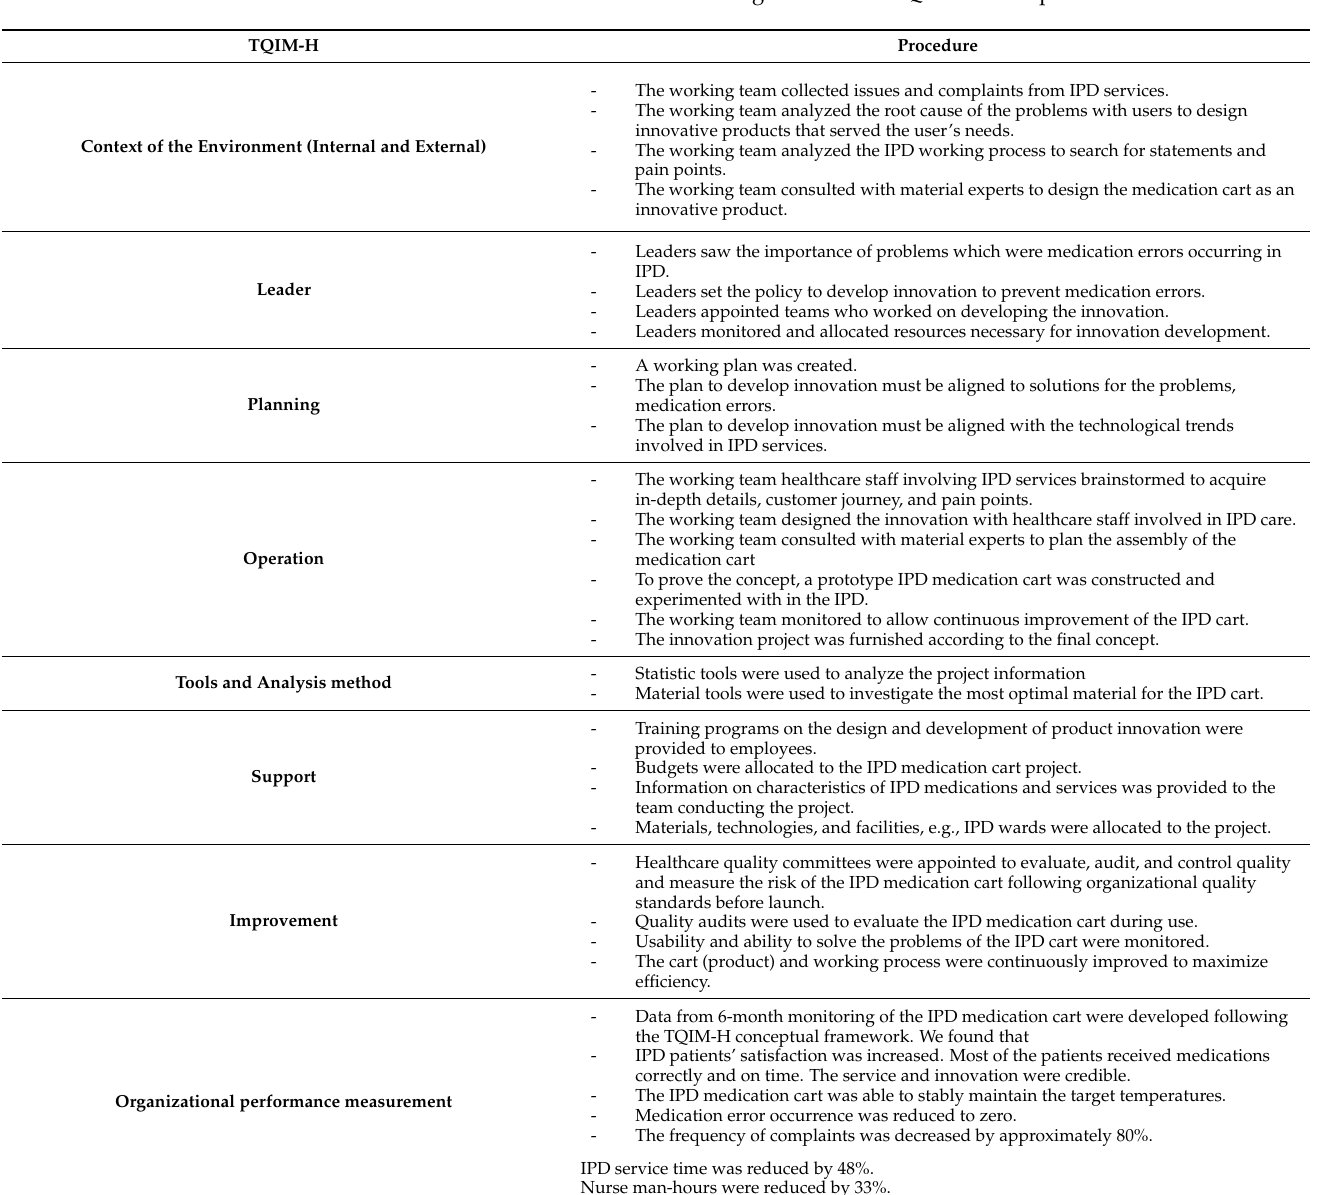
Table 7. The external dataset used for triangulation with TQIM-H conceptual